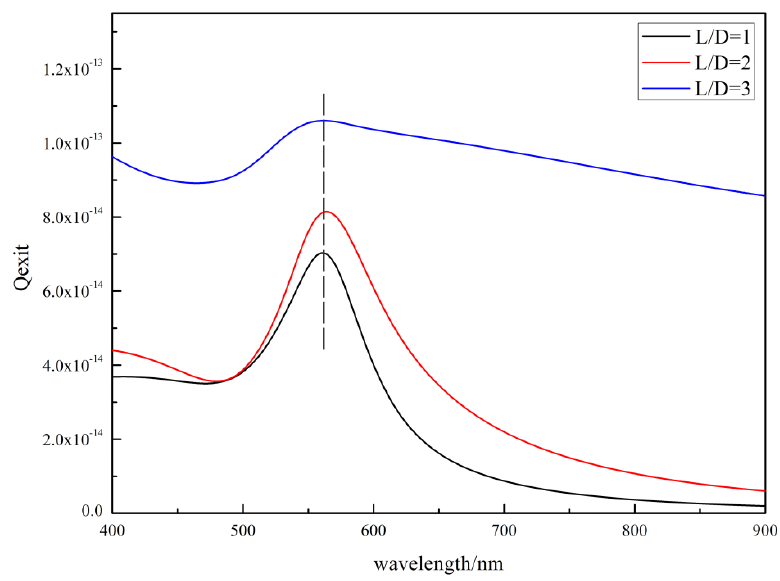
Figure 7. The extinction spectra of isolated Au nanorods with different length-diameter ratios.